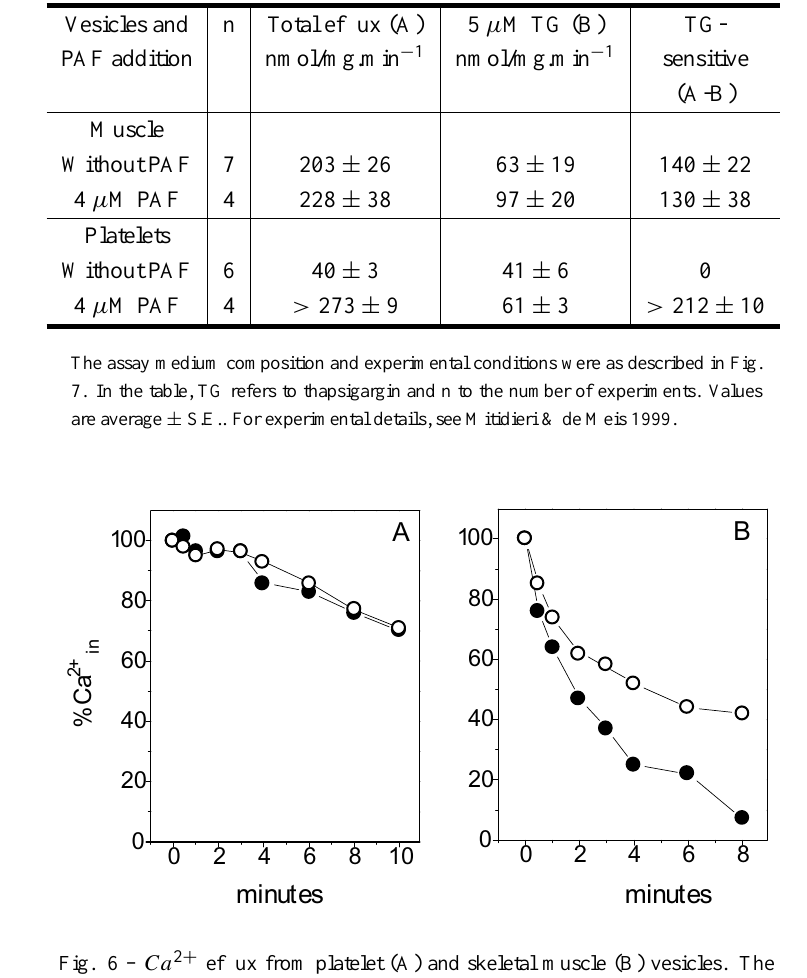
Fig. 6 – Ca 2 + efflux from platelet (A) and skeletal muscle (B) vesicles. The vesicles were preloaded with 45 Ca and diluted to a final concentration of 30 µ g of protein/ml into a medium containing 50 mM MOPS/Tris pH 7.0 and 0.1 mM EGTA either in the absence ( (cid:2) ) or presence ( ❍ ) of 1 µ M